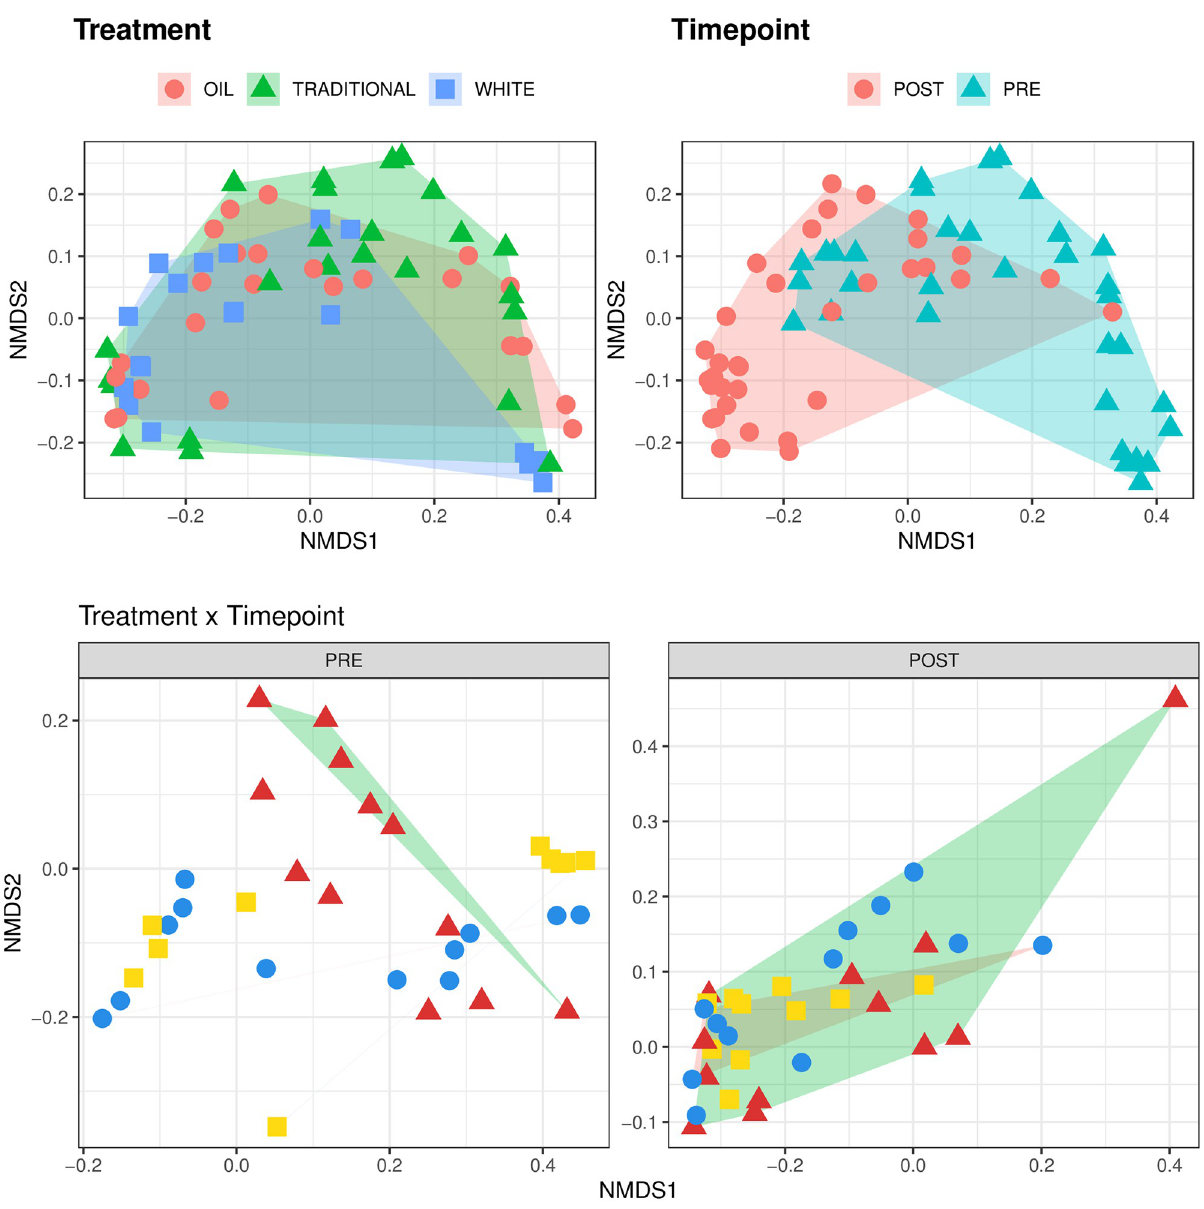
Fig 6. Beta diversity. First two dimensions from the (non-metric) multi-dimensional scaling (NMDS) of Bray-Curtis distances between samples. Samples were grouped by experimental units: by treatment on the upper left pane, by timepoint on the upper right pane, by treatment and timepoint in the lower pane. PERMANOVA among treatments p-value = 0.052, PERMANOVA among timepoints p-value = 0.001 (using 999 permutations), PERMANOVA among treatments by timepoint (pre- vs post-weaning) p-value =